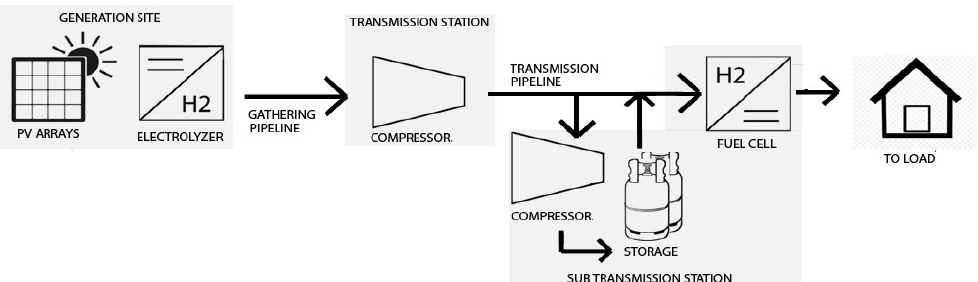
Figure 2. Hydrogen pathway considered. Gathering pipeline is assumed to have negligible costs and efficiency losses. In gas turbine scenarios, the fuel cell is replaced. Fuel cells are modeled with necessary power conversion units.